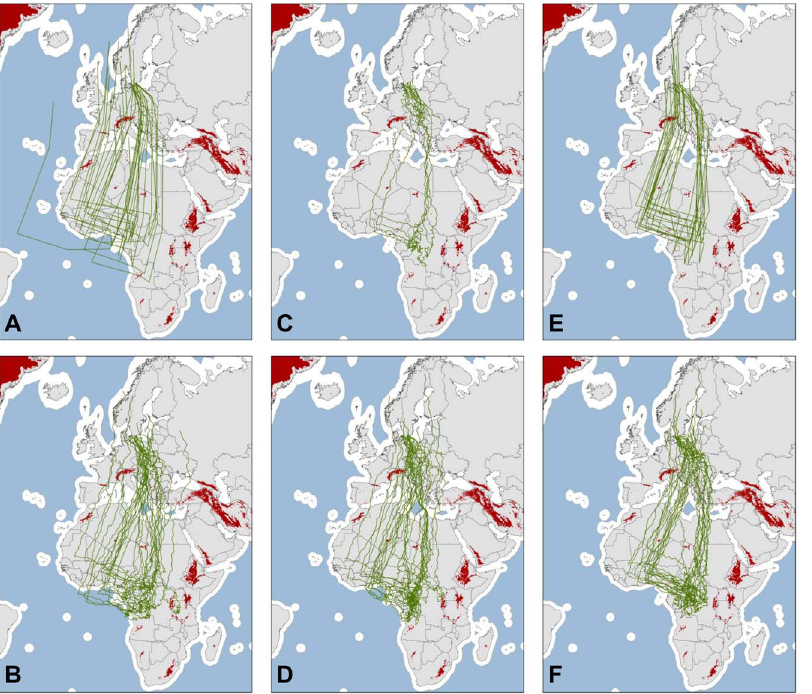
Figure 2. Maps showing examples of 15 random migration routes simulated by vector summation in six different ways. A: simulations using the LONG model, B: SHORT, C: SHORT_Mort, D: SHORT_Dir_Change, E: LONG_Juv_Mort, F: SHORT_Juv_Mort (see Table 1). Blue parts of maps indicate water bodies considered a barrier ( . 200 km from the coast) and red parts indicate mountain barriers (more than 1700 m above sea level). Mercator projection.